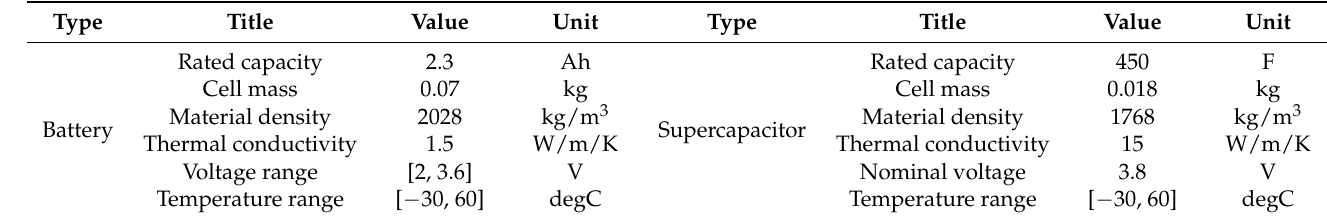
Figure 4. Configuration of the battery pack, supercapacitor pack, and bi-directional DC/DCs in the hybrid energy storage system. Table 2. Basic parameters of battery and